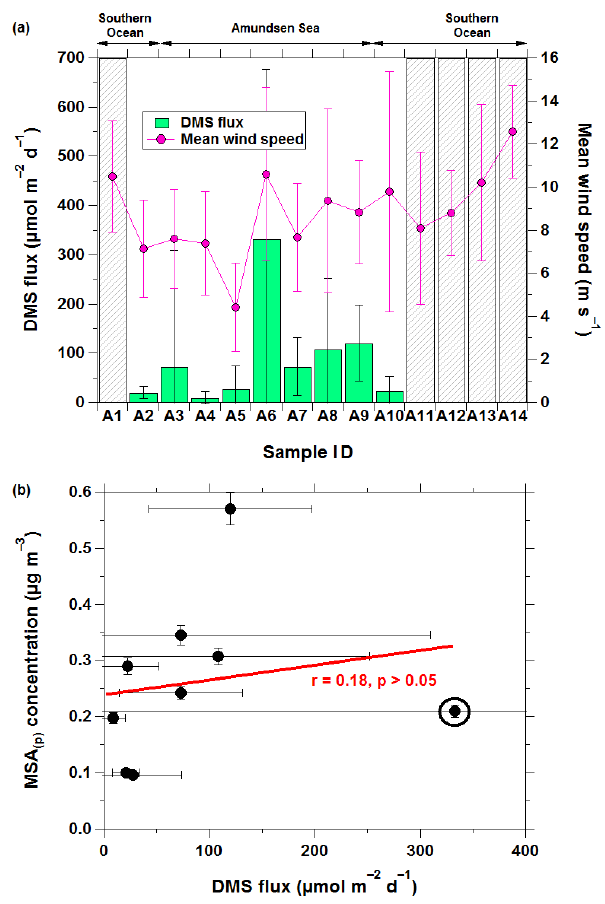
Figure 4. Dimethylsulfide (DMS) flux (reported by Kim et al., 2017) (a) against aerosol sample ID and the correlation between MSA ( p ) concentration and DMS flux (a) . The DMS fluxes were cal- culated using sea surface DMS concentrations and shipboard wind speed data monitored during the cruise. Details of the measurement of the sea surface DMS concentration and DMS flux calculation are given by Kim et al. (2017). Each DMS flux represents its mean value and standard deviation for each aerosol sampling time. The gray hatched areas in (a) denote that no DMS measurement was conducted. The pink solid line with circles in (a) indicates the mean and standard deviation of wind speeds for each aerosol sampling time. Double arrows in (a) show the sampling locations of aerosol samples. In (b) , the red line indicates the correlation between the MSA ( p ) concentration and DMS